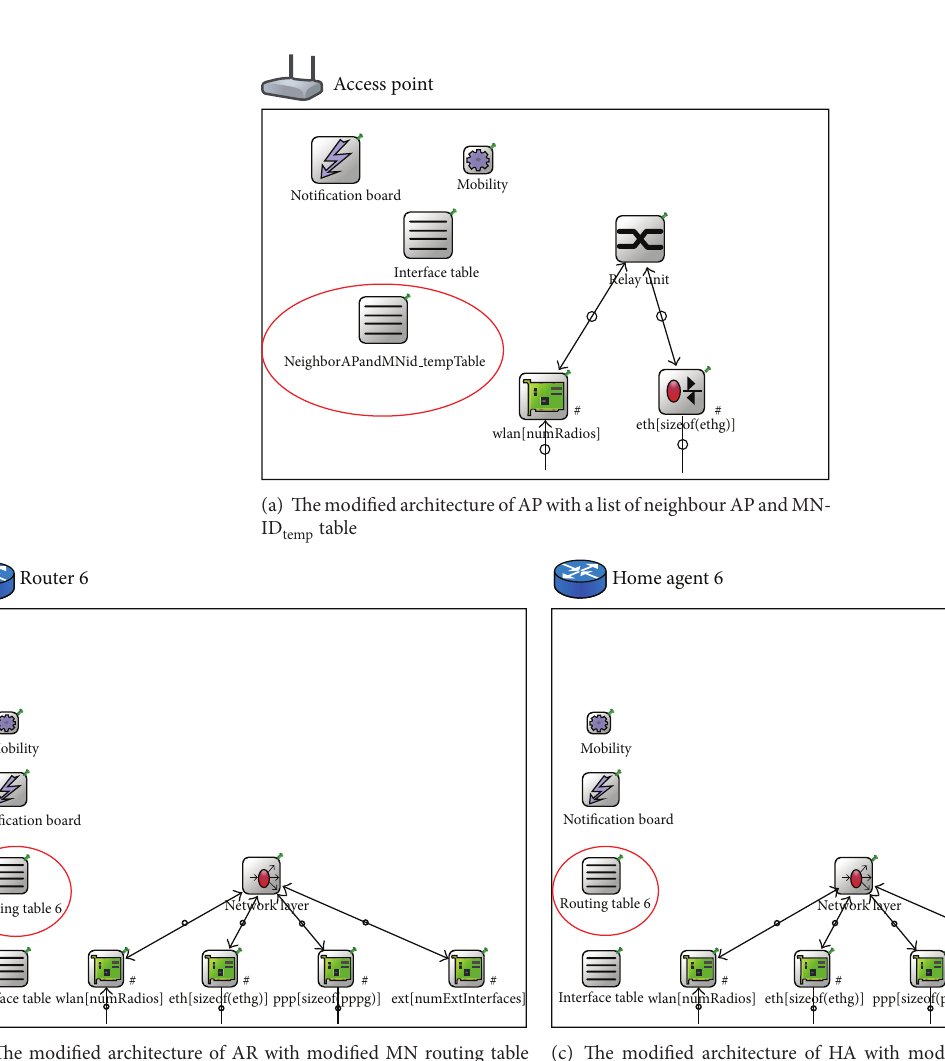
(c) The modified architecture of HA with modified MN routing table format